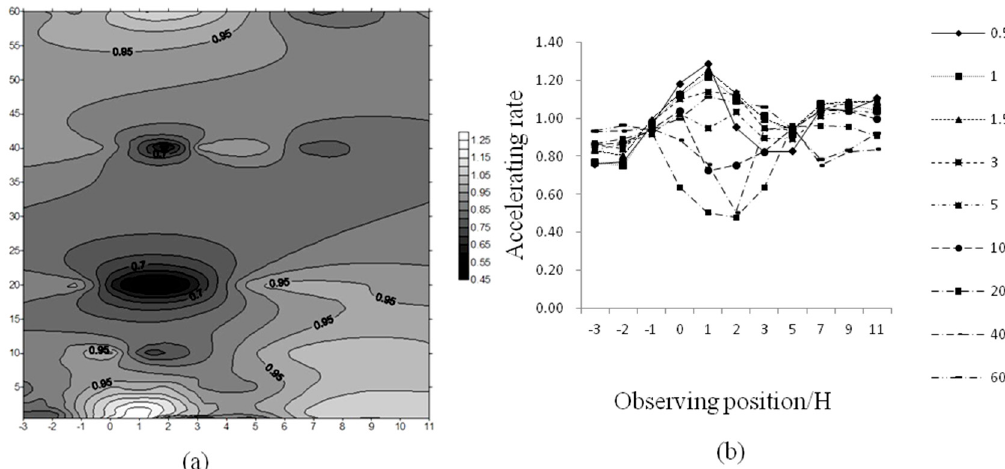
Figure 5. Isolines ( a ) and variation trend of accelerating rate ( b ) of 16 m/s [13]. Note: The left graph is the contour map of acceleration rate, and the right graph is the trend line of acceleration rate change at different heights. The abscissa of the left graph is the observation position/H, the field plots “-” at the windward side, the field plots “+” at the leeward side, H = 40 cm, and the ordinate is the height/cm.